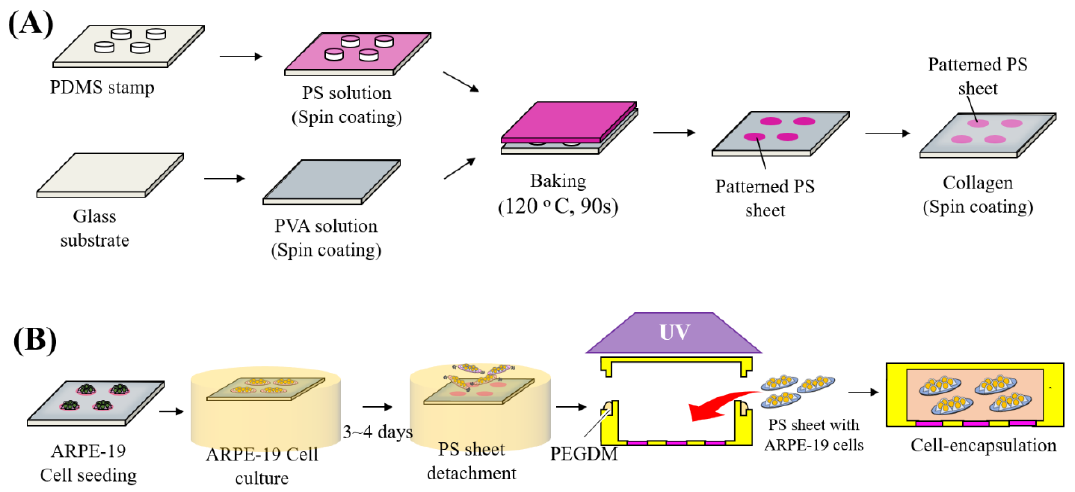
Figure A2. Fabrication of PS sheet, cell culturing, and cell encapsulation. ( A ) PS sheets were patterned in a glass substate coated with PVA. Collagen was spin coated on the PS sheet to culture ARPE-19 cells. ( B ) ARPE-19 cells cultured on the PS sheet could be easily removed once the PVA substrate was dissolved. Cells were then encapsulated inside the capsule by bonding the cap and the reservoir with a UV curable PEGDM resin.